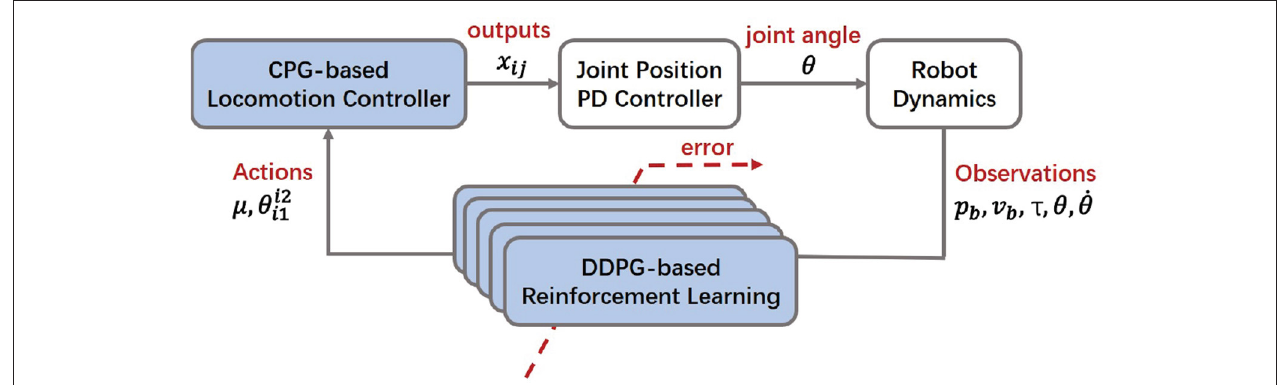
FIGURE 3 | Diagram of the proposed bio-inspired control scheme. The proposed control scheme has a cascaded structure with a feedback loop. It consists of three parts: (1) A dynamic model (with a embedded PD controller) that computes torque commands to handle robot dynamics subject to mechanical constraints. The